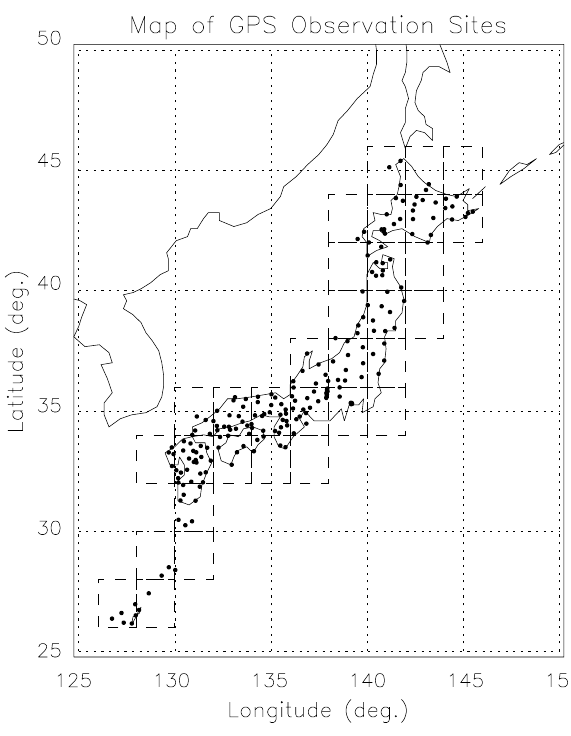
Fig. 2. Dual frequency receivers of GEONET distributed nation- wide. The dash lines separate the area enclosed into 32 meshes. The size of the mesh is 2 ◦ by 2 ◦ in longitude and latitude, respec-